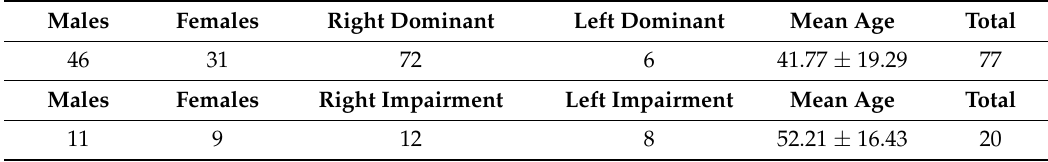
Table 1. Summary of participant data.